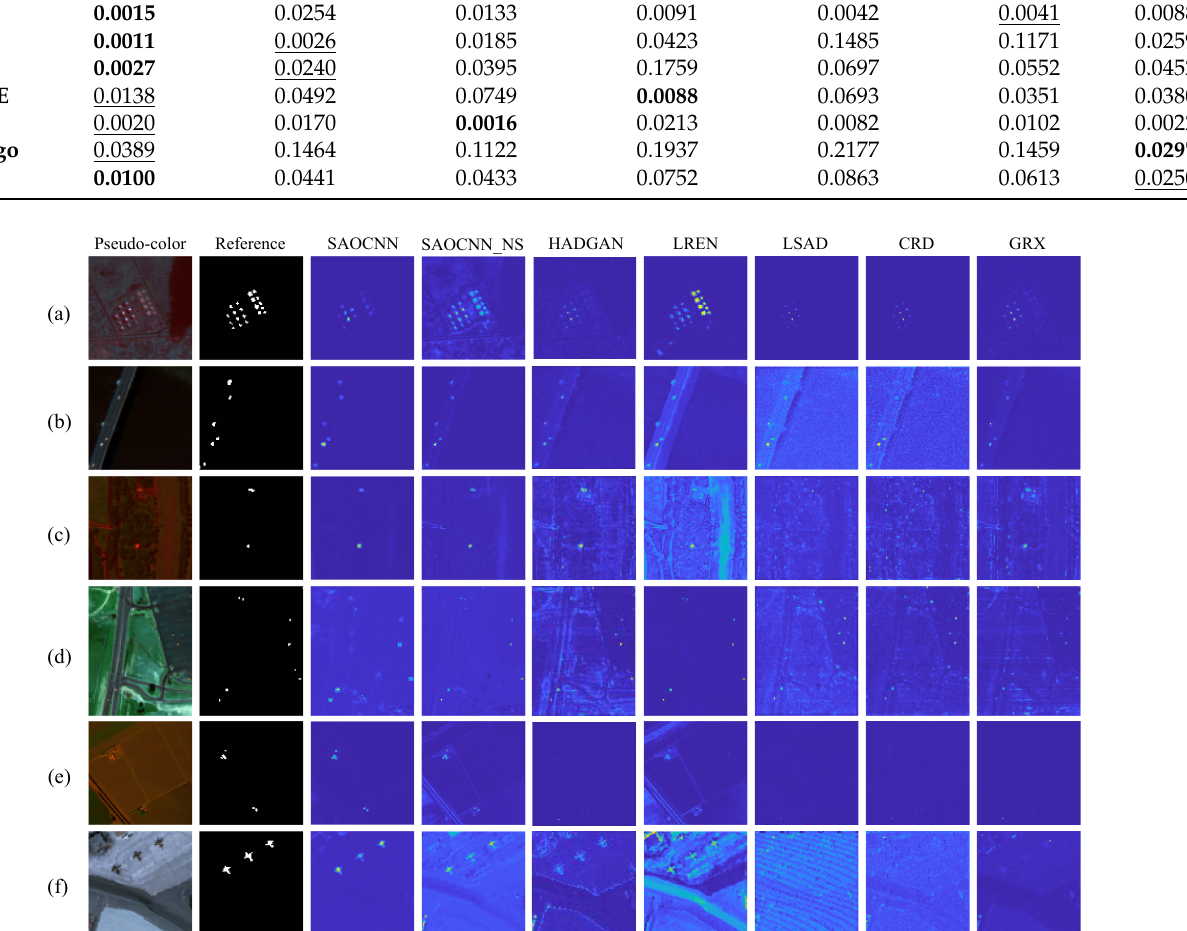
Figure 6. Anomaly detection maps of SAOCNN, SAOCNN_NS, HADGAN, LREN, LSAD, CRD, and GRX. ( a ) Coast. ( b ) Pavia. ( c ) DC Mall. ( d ) HYDICE. ( e ) Salinas. ( f ) San